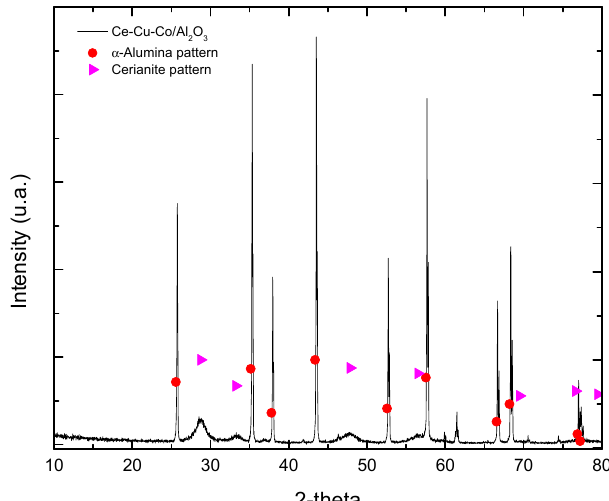
Figure 1. XDR of the mixed oxide catalyst Ce-Cu-Co/ α -alumina.